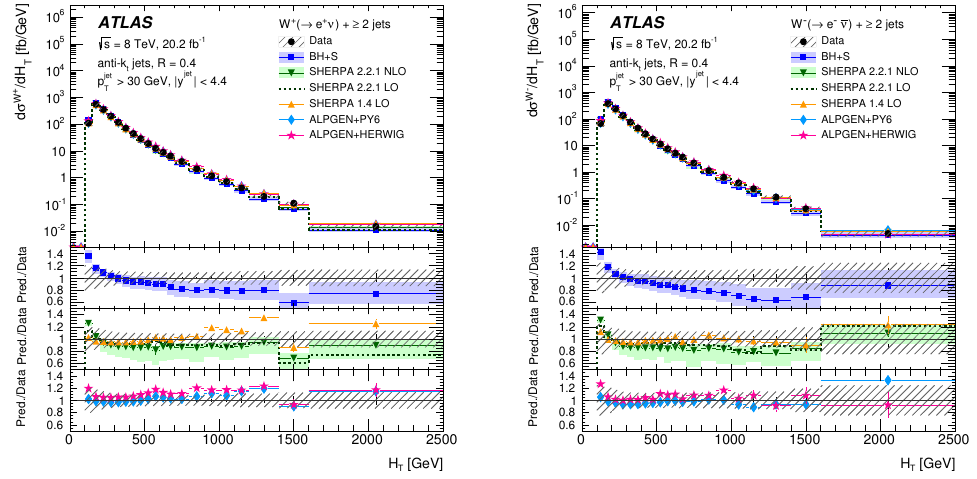
Figure 25 . Di(cid:11)erential cross sections for the production of W + (left) and W (cid:0) (right) as a function of the H T for events with N jets (cid:21) 2. For the data, the statistical uncertainties are indicated as vertical bars, and the combined statistical and systematic uncertainties are shown by the hatched bands. The uppermost panel in each plot shows the di(cid:11)erential cross sections, while the lower panels show the ratios of the predictions to the data. The theoretical uncertainties on the predictions are described in the text. The arrows on the lower panels indicate points that are outside the displayed range.